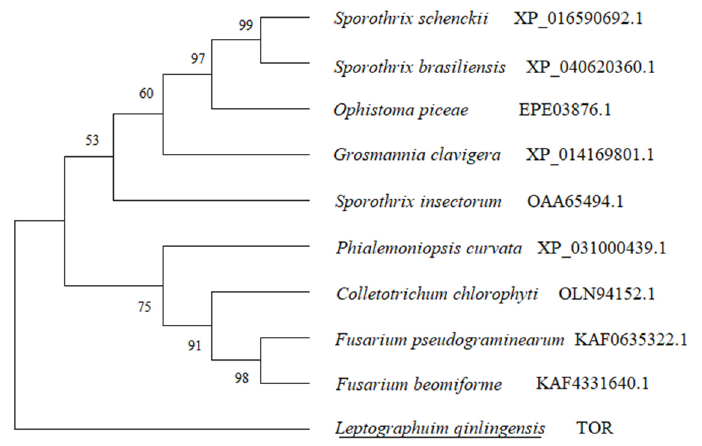
Figure 1. Phylogenetic analysis of the TOR genes from L. qinlingensis and other fungi with the amino acid sequences. The maximum likelihood tree was performed using the amino acidic substitution model LG + G + I ( − lnL = 42,370.551, G = 2.04). The TOR amino acid sequence of L. qinlingensis are underlined.